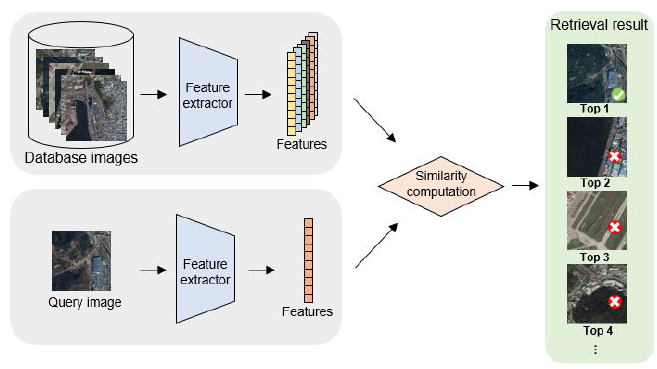
Figure 1. Illustration of the remote sensing image retrieval process. Features are extracted from database and query image, and the Euclidean distance between them is calculated to determine the priority. Images are retrieved in order based on the minimum Euclidean